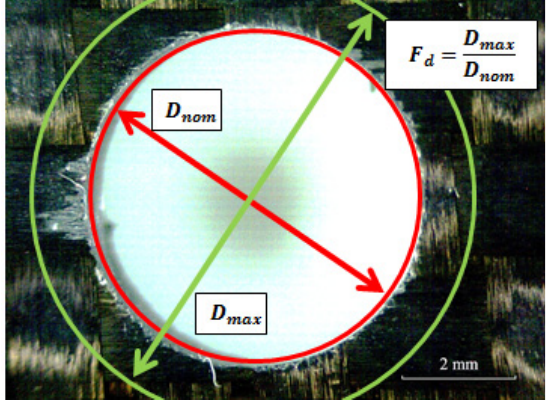
Figure 3. Example of delaminated specimen for calculation of delamination factor F